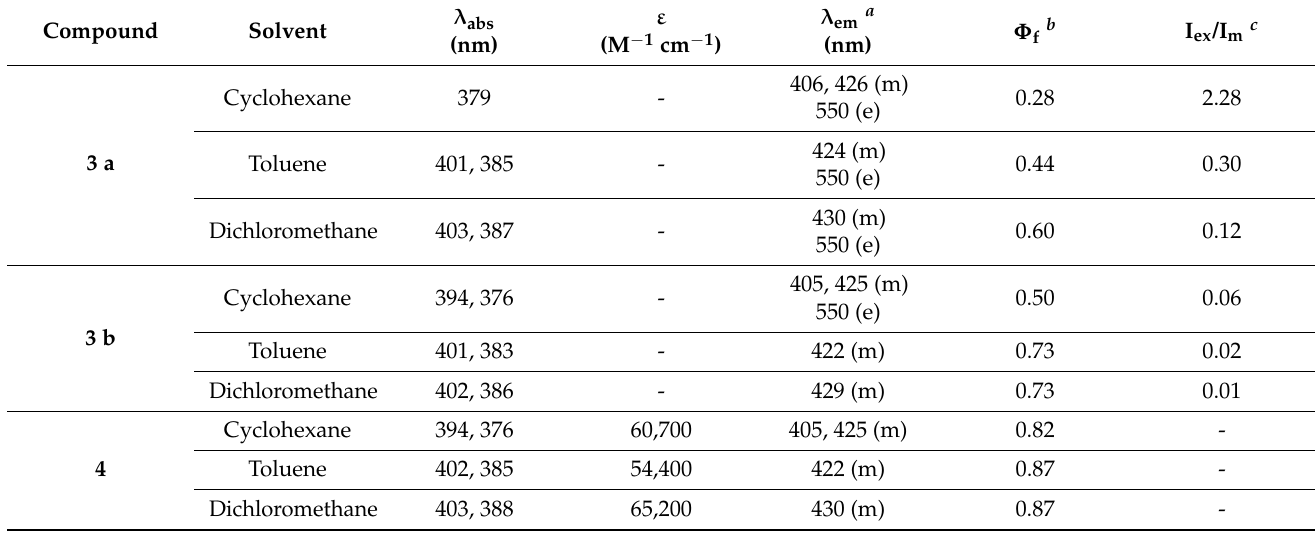
Figure 20. Schematic representation of the physical network formation in polymers 3 a,b after heating to 120 °C.